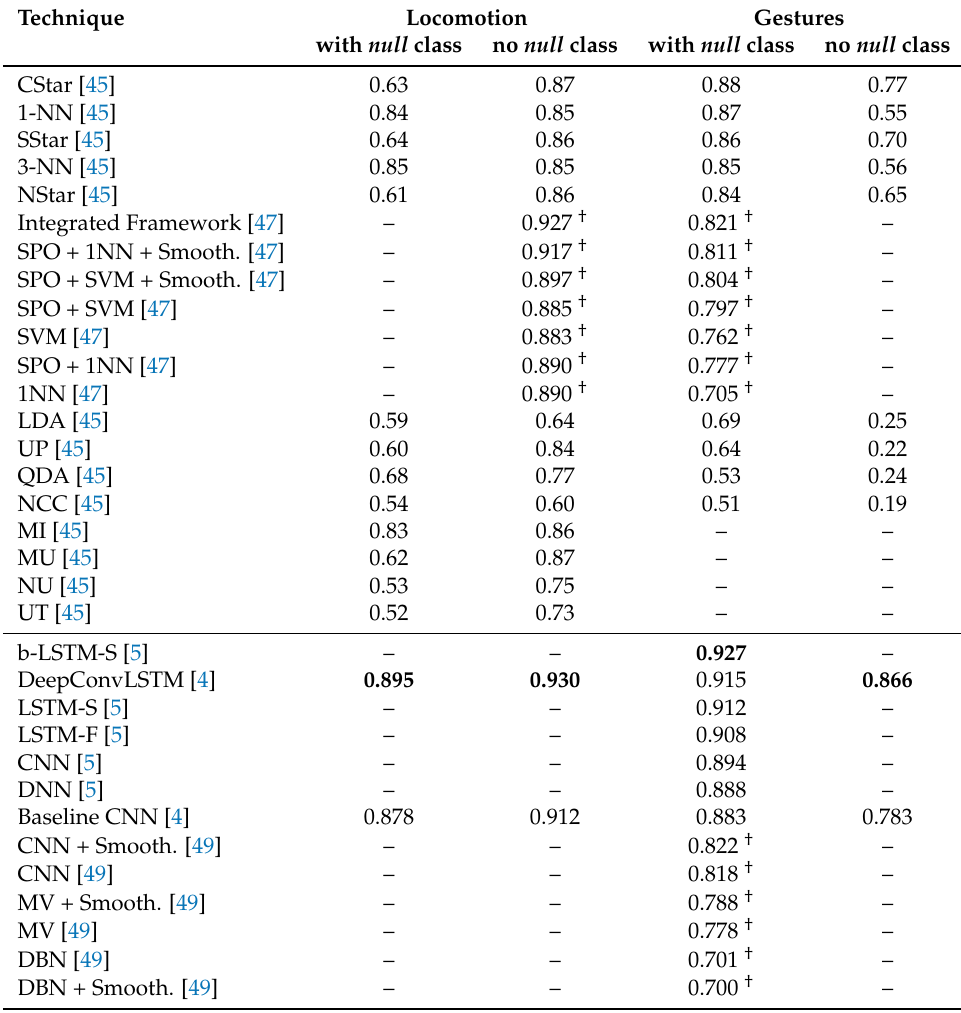
Table 3. Side-by-side comparison of the most relevant results provided in the state-of-the-art for the OPPORTUNITY dataset, including both the locomotion and the gesture recognition tracks, with and without null instances. The dagger (†) near some values indicate that performance was reported in a subject-per-subject basis, and are the outcome of averaging the F1 score for subjects 2 and 3. NN: nearest neighbors; SPO: structure preserving oversampling; SVM: support vector machines; LDA: linear discriminant analysis; QDA: quadratic discriminant analysis; NCC: nearest centroid classifier; LSTM: long short-term memory; CNN: convolutional neural network; DNN: deep feed-forward neural network; MV: means and variance; DBN: deep belief network; UP, MI, MU, NU and UT are not technical acronyms but the names given by Chavarriaga et al. [45] to different works based on the name of the institutions participating in the OPPORTUNITY